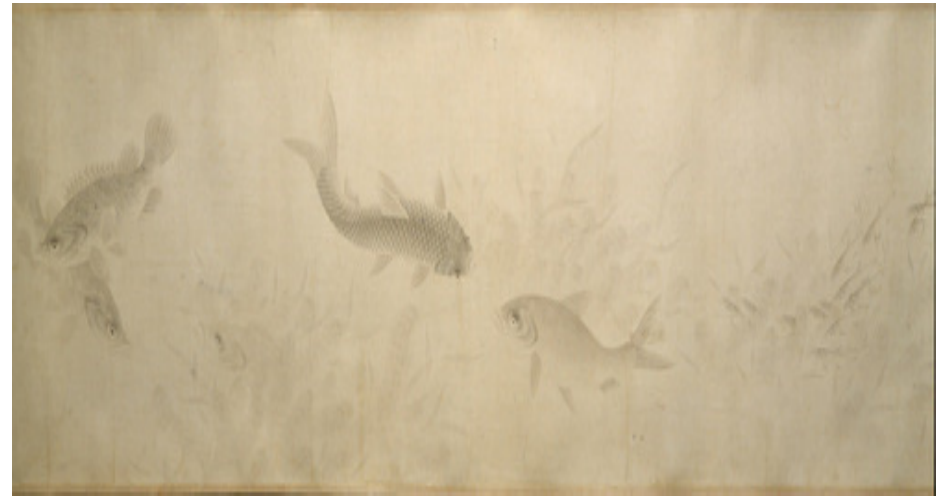
Figure 3. “Yúlè 魚樂 ” (The Joy of Fish; dat. 1291) by Zh ō u D ō ngq ī ng 周東卿 (fl. 1280–1300). Figure 3. “Y ú l è 魚 樂 ” (The Joy of Fish; dat. 1291) by Zh¯ou D¯ongq¯ıng 周 東 卿 (fl. 1280–1300)